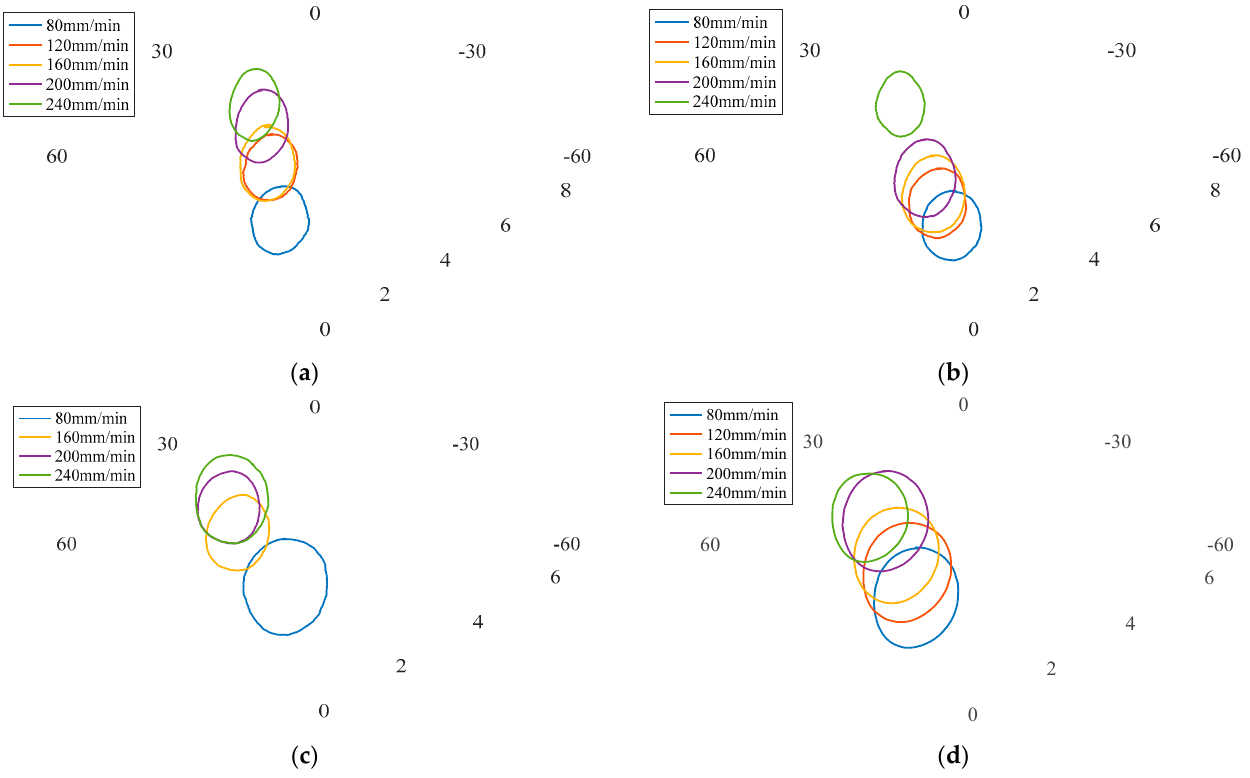
Figure 14. Representation of in-plane forces in polar coordinate system under rotational speeds of ( a ) 300 r/min; ( b ) 400 r/min; ( c ) 500 r/min; ( d ) 600 r/min.